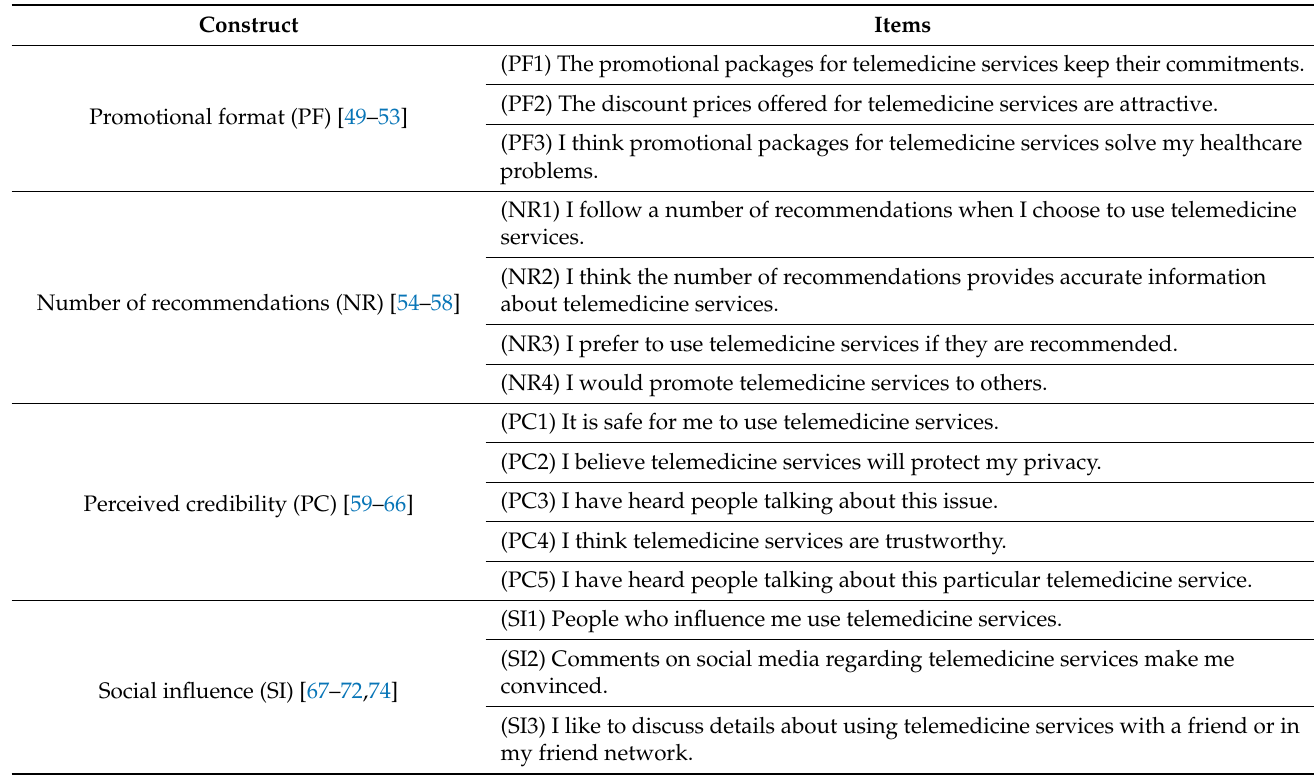
Table 1. Measurement items and descriptive statistics for all variables.